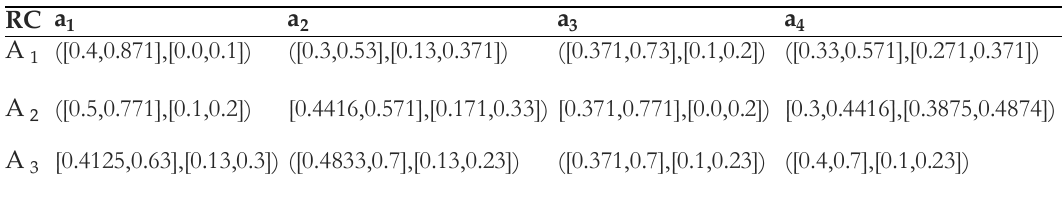
Table 4. Collective reflexive